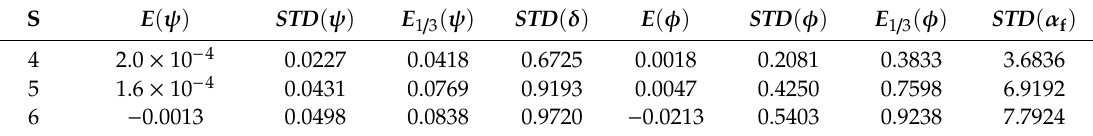
Figure 4. Simulation curves of the ship roll/yaw motions using H ∞ -SFMPC in different sea states at the encounter angle of 90°. Table 2. simulation results of the ship roll/yaw motions in different sea states at the encounter angle of 90°.